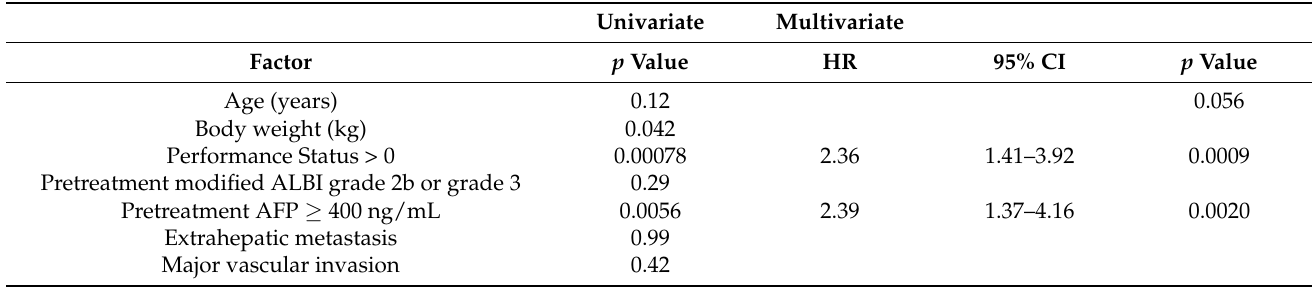
Table 7. Factors associated with mortality in lenvatinib therapy (MTT experienced